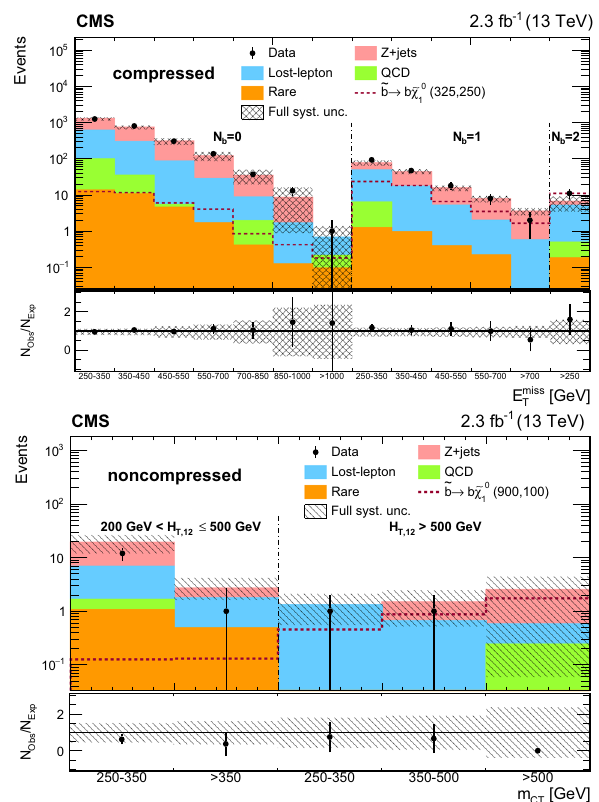
Fig. 6 Observed events and estimated SM background and signal yieldsforthecompressed( top )andnoncompressed( bottom )SRsforthe bottom squark search in the all-jet final state. The observed data yield is shown as black points and the total background predictions are shown in solid area . The SM background predictions shown do not include the effects of the maximum likelihood fit to the data. The bottom panel shows the ratio of data to the total background prediction in each search bin. Only statistical uncertainties are propagated to the